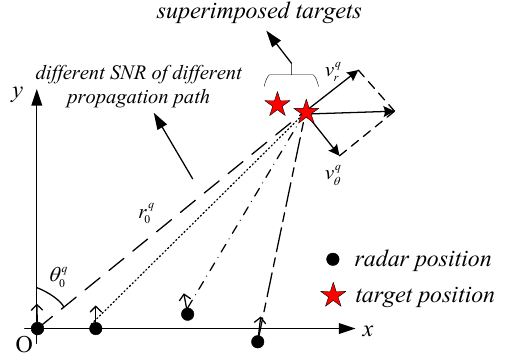
Figure 2. Topology diagram of MIMO radar and targets, which shows two practical problems concerned in this paper: (1) target echo overlap, (2) different signal-to-noise ratios (SNRs) in different propagation